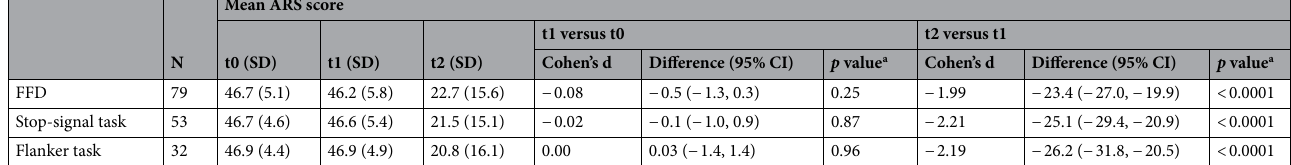
Table 2. Mean ARS scores at t0, t1 and t2 for the FFD group and the subgroups included in the fMRI tasks. ARS attention-deficit hyperactivity disorder (ADHD) rating scale (minimum = 0, maximum = 54), CI confidence interval, FFD few-foods diet, SD standard deviation, t0 screening, t1 before start FFD, t2 at the end of the FFD. a Paired t